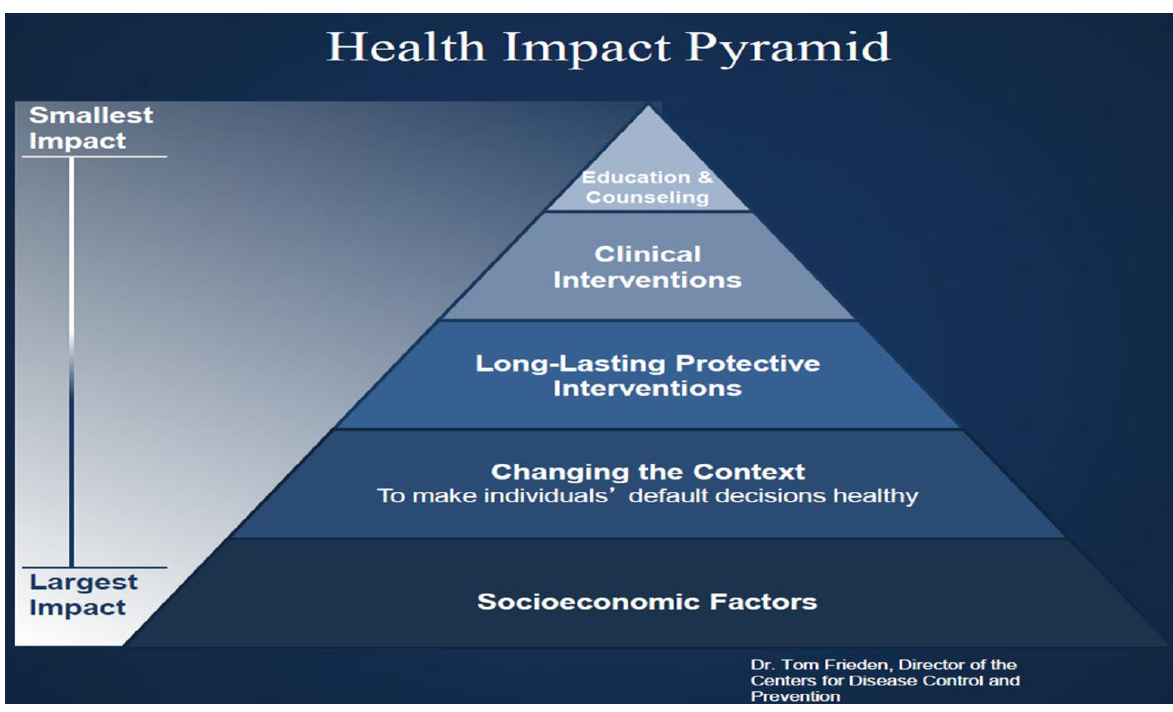
Figure 1. Health Impact Pyramid (Frieden,